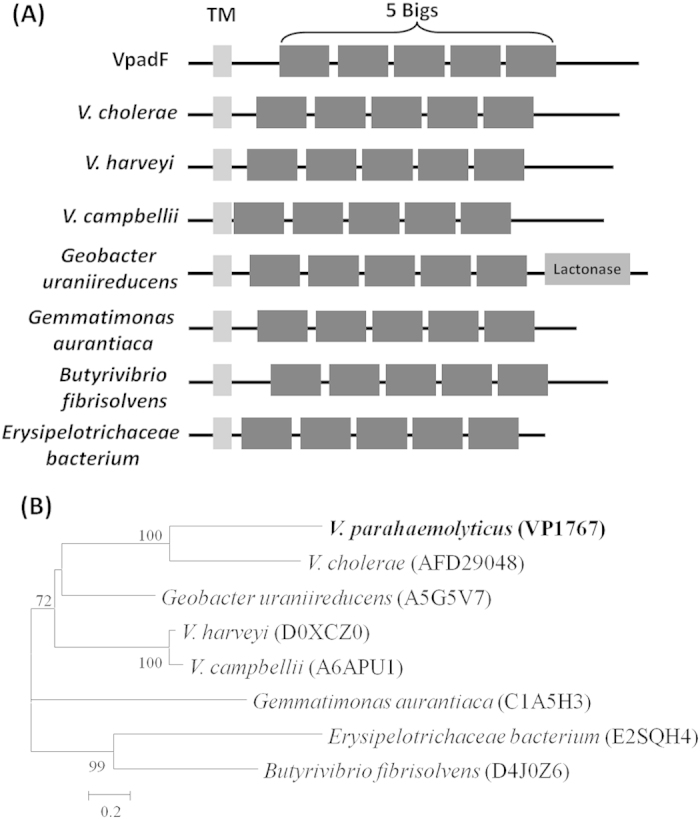
Schematic representation and phylogenetic analysis of VpadF.(A) Schematic representation of VpadF and its homologues; (B) Neighbor-joining tree based on five Bigs sequences showing the phylogenetic relationships of VpadF and its homologues. The protein sequences were obtained from either NCBI or UniProt. Bootstrap values (>50%) are shown at branch nodes. Bar, 0.2 difference at the amino acid level.